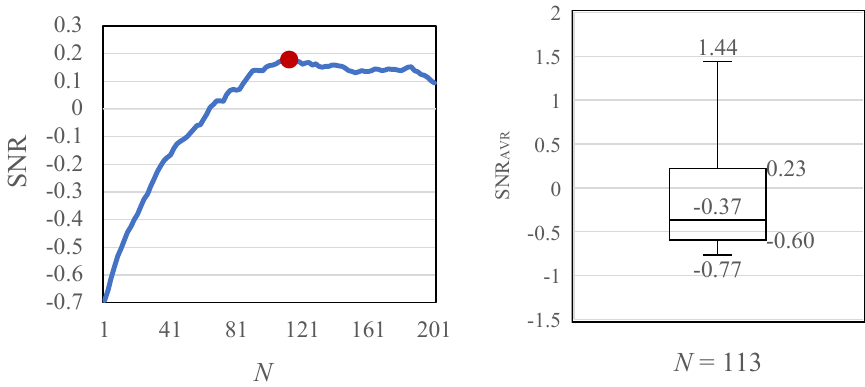
Figure 13. Determination of optimal kernel size N . SN AVF = 0.179 was achieved when the optimal kernel N = 113.